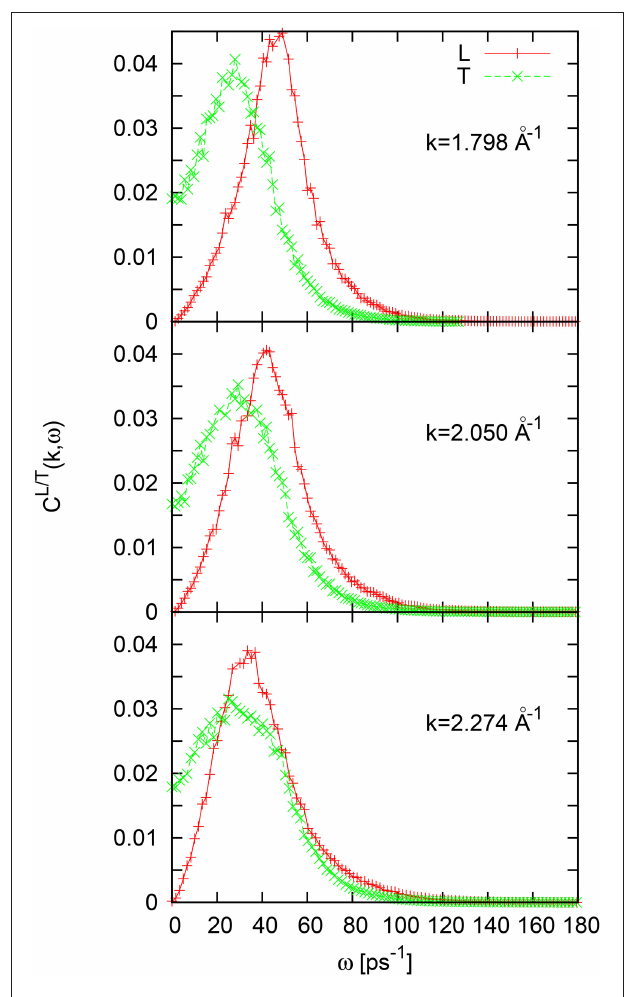
FIGURE 7 | Longitudinal and transverse current spectral functions for liquid Ni for three wave numbers in the second pseudo-Brillouin